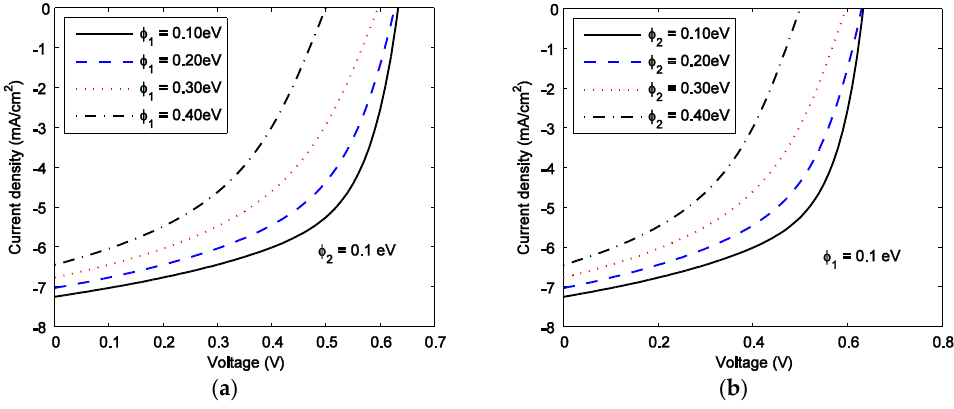
Figure 8. Theoretical net current density versus voltage curves of P3HT:PCBM solar cells for varying ( a ) electron injection barrier ( φ 1 ), and ( b ) hole injection barrier ( φ 2